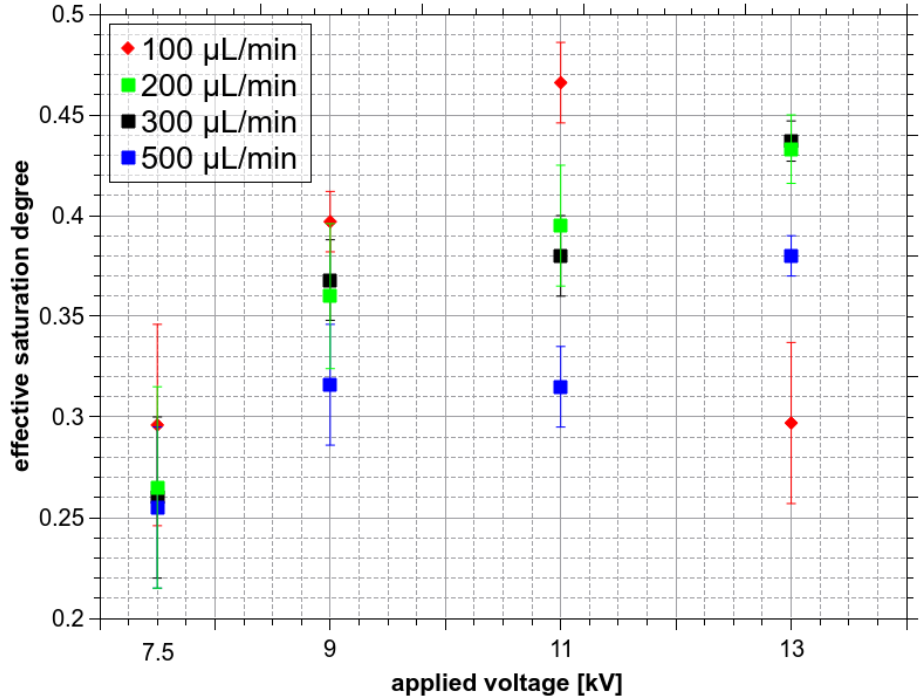
Figure 14. Effective O 3 saturation degree ξ eff of flying microdroplets as a function of V a (kV) at different Q w (µL/min) .